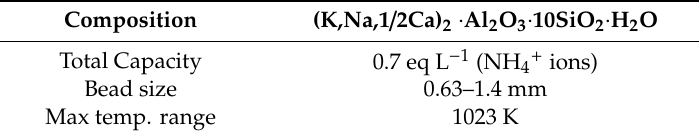
Table 1. Characteristics of